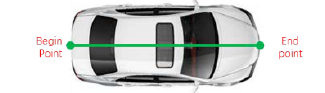
Fig. 2 The spatial relationship between the vehicle and